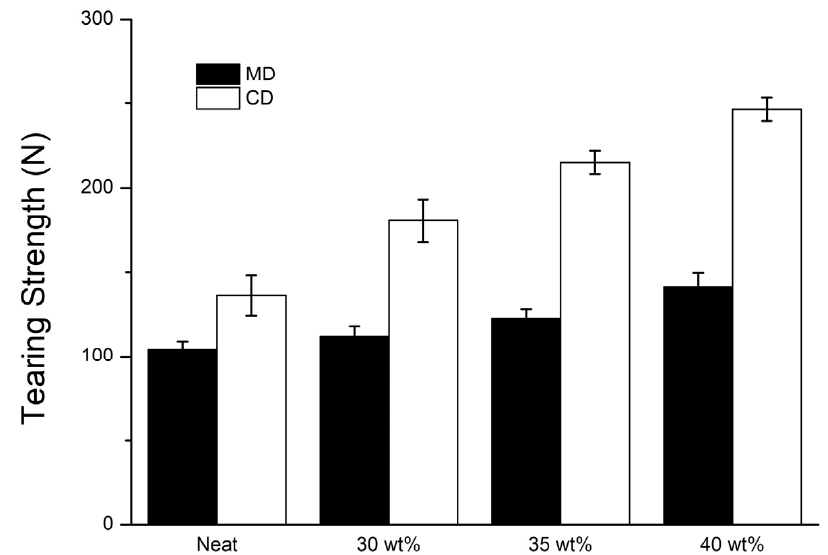
Figure 7. Tearing strength of STF composite nonwoven fabrics as related to the STF concentration.